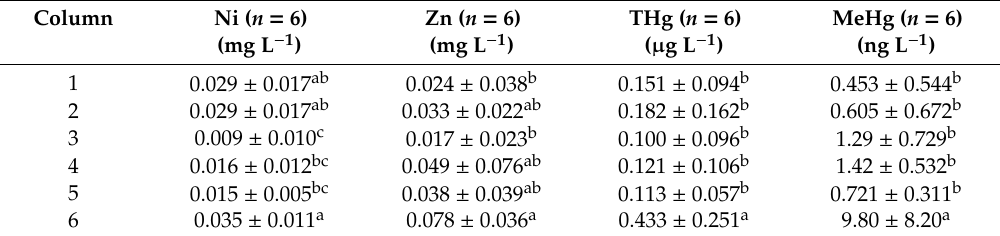
Table 7. Metal concentrations in six columns after adding acid (day 101–135) Column